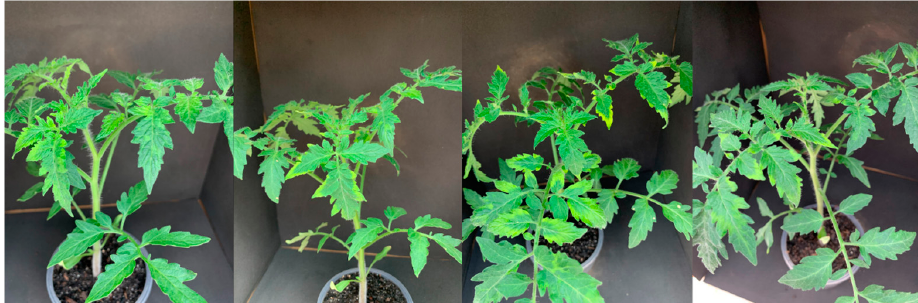
Figure 11. Symptoms evolution in tomato plants due to simulated hexazinone drift at dose ratios 1/16D, 1/32D, and 1/64D (24.75, 12.38, and 6.9 g a.i. ha − 1 , respectively) of the recommended dose (D). Evaluations were made from 1 to 7, 14, and 21 days after application (DAA). Front view ( A ) and top view ( B ) of tomato plants a ff ected by simulated drift.